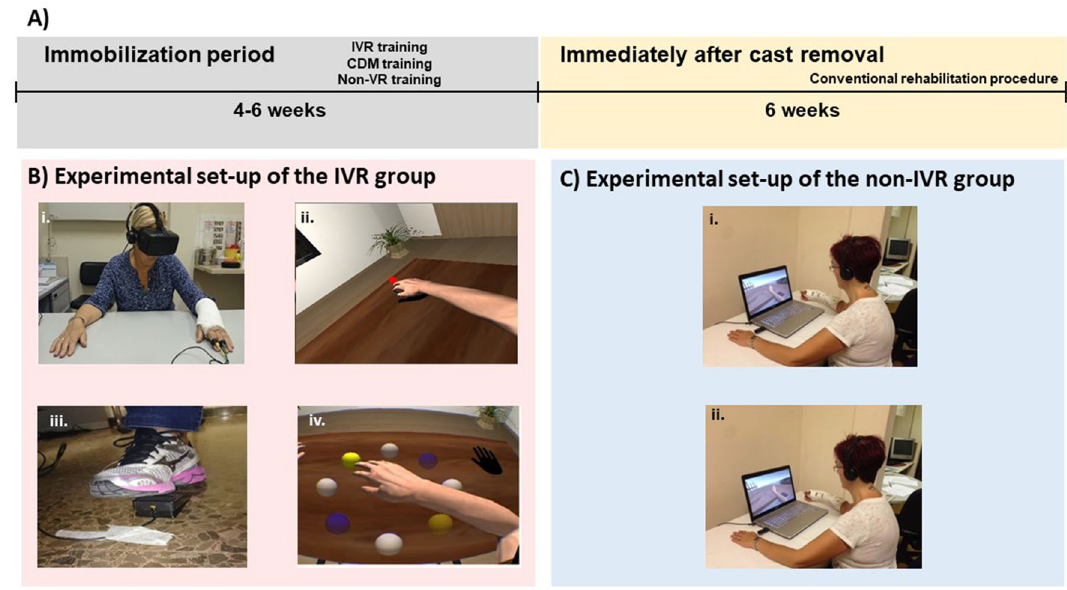
Figure 1. Experimental design. ( A ) Timeline of the study design. ( B ) Experimental set-up of the immersirve virtual reality (IVR) group. (i) The patient used a head-mounted display (HMD) that provides an immersive virtual environment and allows the participant to feel embodied in a virtual body viewed from a first-person perspective. They also wore headphones through which they could listen to the task instructions and movement descriptions during the whole session. The virtual arms were co-located with the real arms. (ii) The red ball repeatedly tapped the fingers during the visuo-tactile stimulation phase at the beginning of each session. Participants were asked to look at the fractured virtual arm throughout the session. Next, the patient listened to the description of the movements and then had to mentally plan the movement. (iii) Once the patient had mentally planned the movement, they had to push the pedal to activate the virtual arm movement. (iv) Finally the patient saw the virtual arm movement (visual feedback of the planned movement), from a first-person perspective. (Motor imagery/action planning + Action observation paradigm). ( C ) Experimental setup of the non-immersive VR group. (i) The patient sat in front of the computer with their arms placed above the table co-located with the virtual arms. The patient wore headphones in order to be isolated from the external noise. (ii) The patient looked at the virtual arm movements from a third-person perspective (Action observation